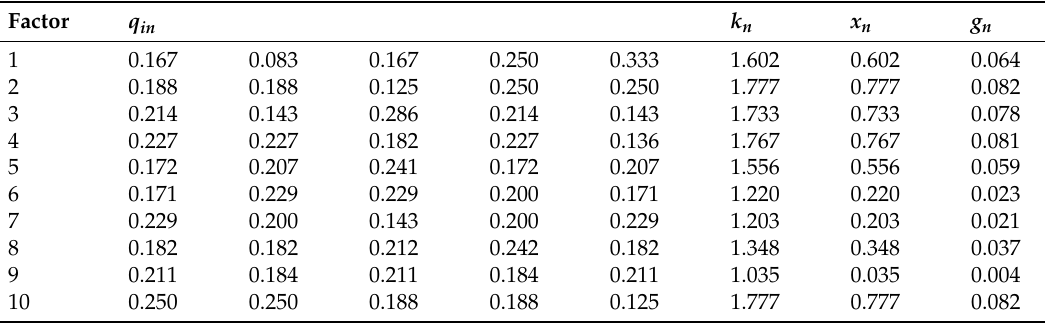
Table 2. Entropy method to determine the weight of each